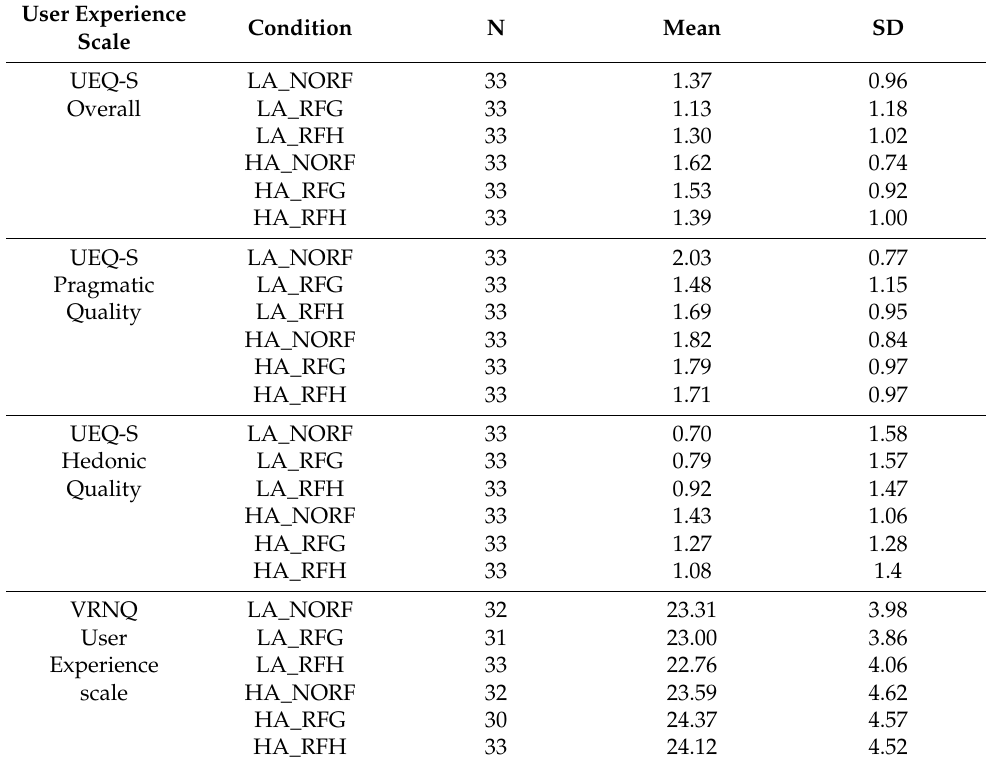
Table 12. Subjective user experience levels assessed by UEQ-S and VRNQ (User Experience Section) Questionnaire. The results are presented by game conditions.